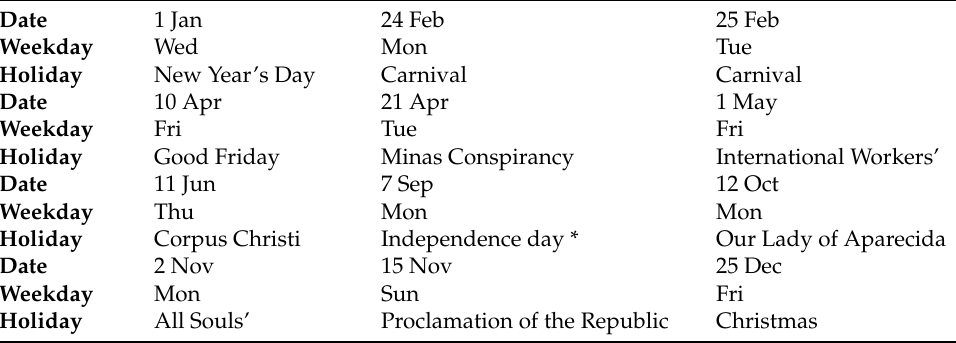
Table 2. Brazilian Holidays. * According to Regulamentation N ◦ 2.621/GM-MD, published on 5 August [19], the Brazilian Ministry of Defense prohibited the Army Forces from participating in commemorative events that could result in crowding, such as parades and military